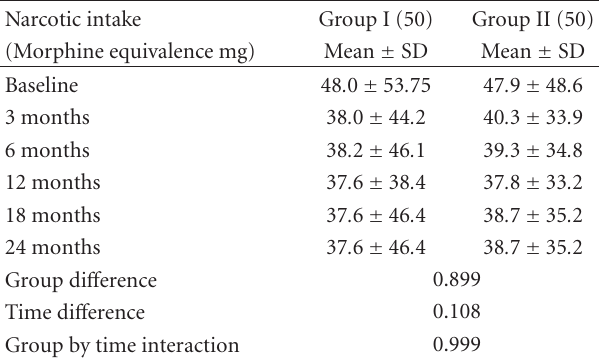
Table 5: Opioid intake (morphine equivalence